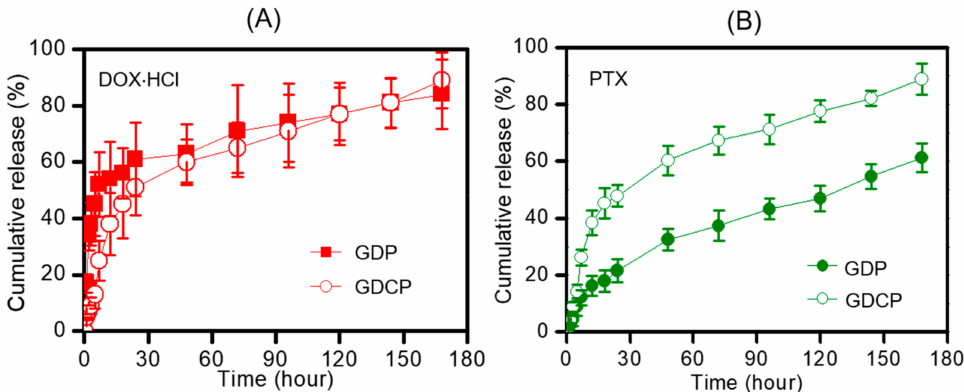
Figure 2. Release behaviors of ( A ) DOX · HCl and ( B ) PTX in GDP and GDCP hydrogels analyzed for 180 hours. These experiments were carried out three times at 37 ◦ C under 100 rpm. These values were expressed as the mean ± standard deviation.